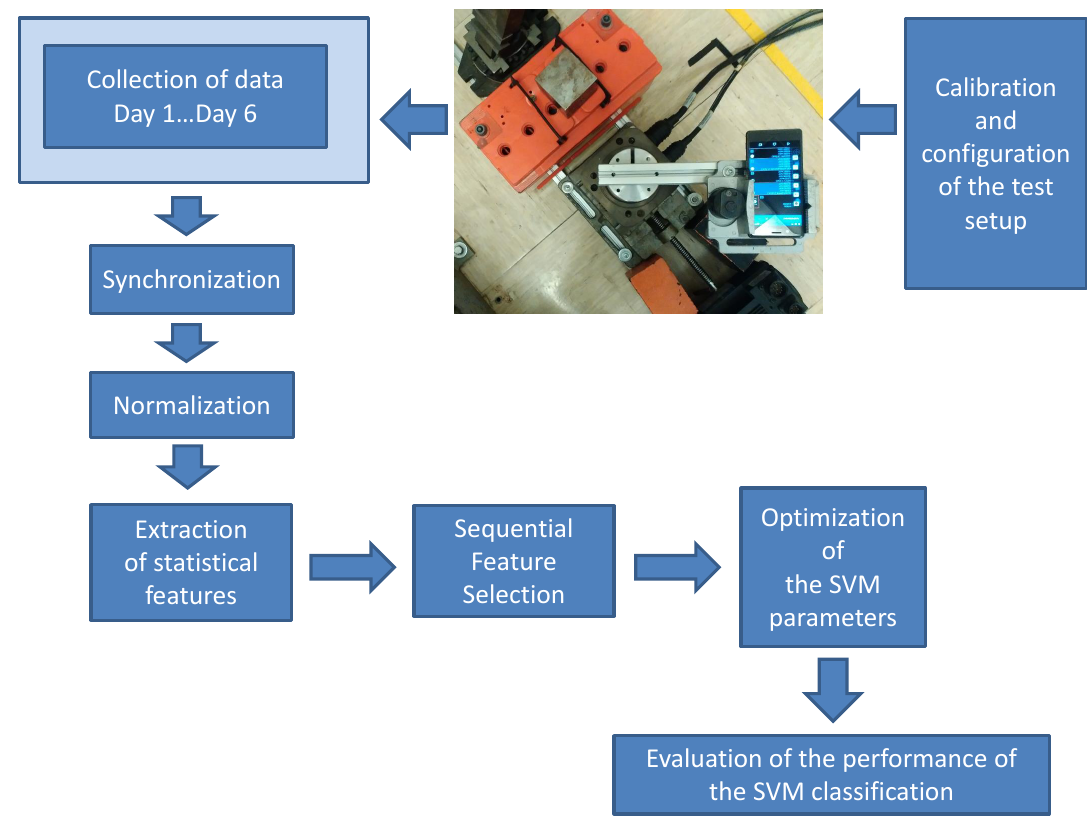
Figure 1. Methodology used to classify mobile phones using the built-in